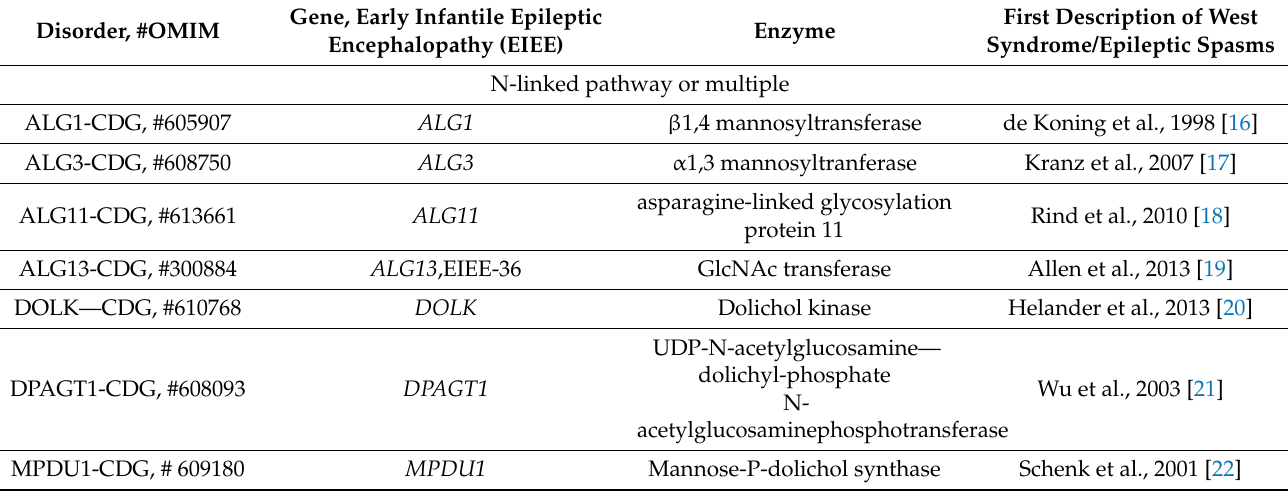
Table 1. Congenital disorders of glycosylation (CDG) types connected with Epileptic Spasms (ESp)/West Syndrome (the names of the diseases are given following the Online Mendelian Inheritance in Man ® , OMIM